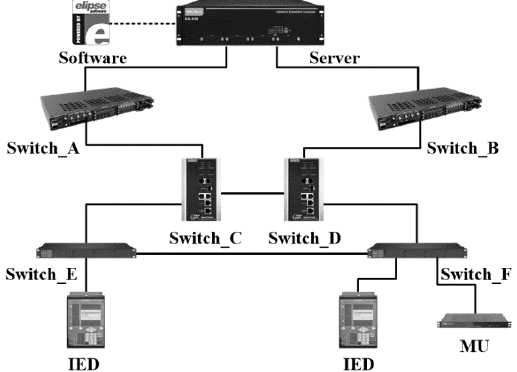
Figure 4. The hardware configuration of the example platform. Table 4. Server status data and status evaluation.